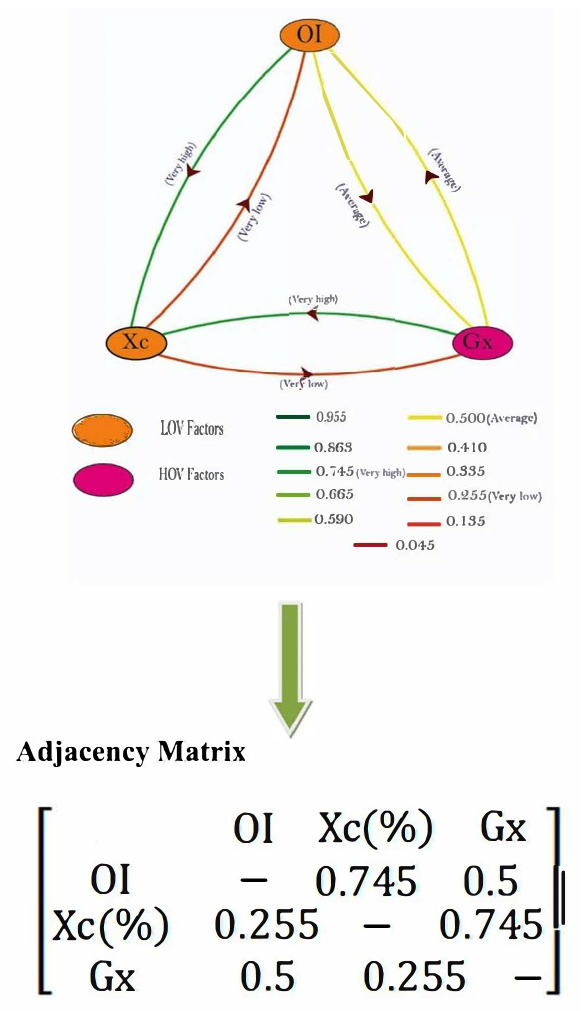
Figure 5. Composite assessment graph with corresponding adjacency